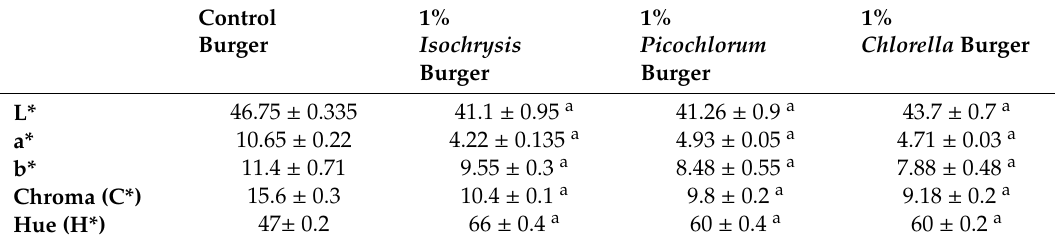
Table 5. Color analysis of control burgers and microalgae-fortified